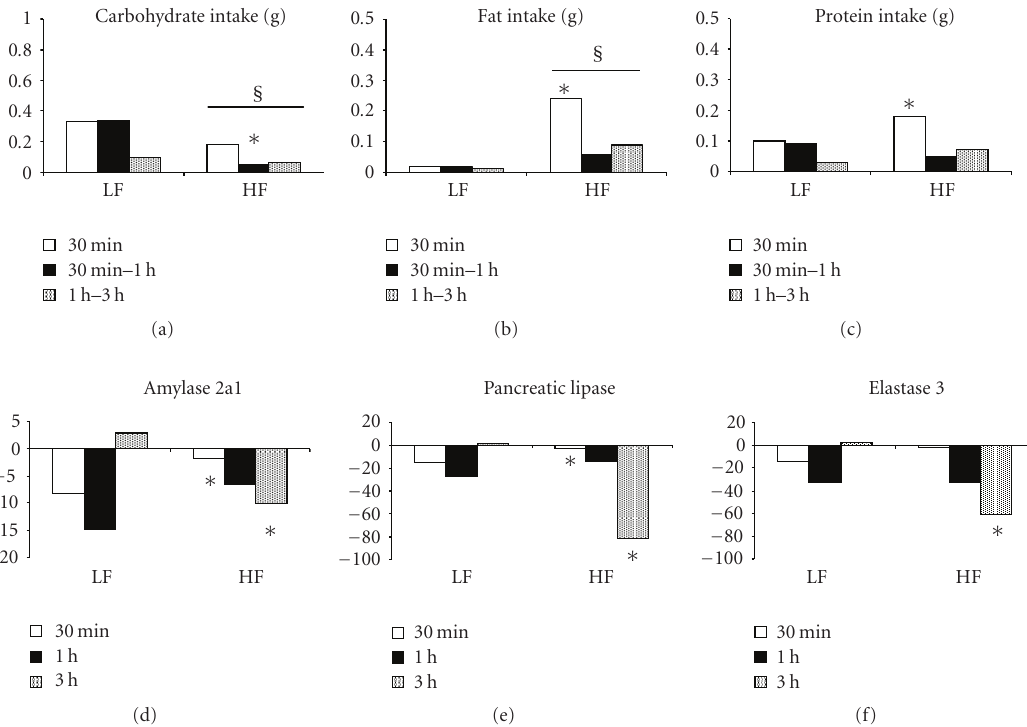
Figure 2: Thirty minutes average nutrient intake (a, b, c) and the correspondent digestive enzyme-coding gene fold-change regulation by feeding (d, e, f). ∗ Significantly di ff erent compared to low-fat (LF) meal at the same time point ( P < . 05). § Significant e ff ect of the diet ( P < . 05). Abbreviations: g, grams; LF, low fat; HF, high